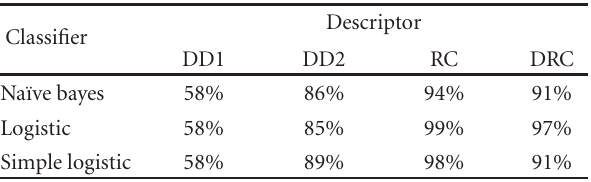
(a) Overall classification rate using di ff erent classifiers (300 training sam- ples, 100 testing samples from